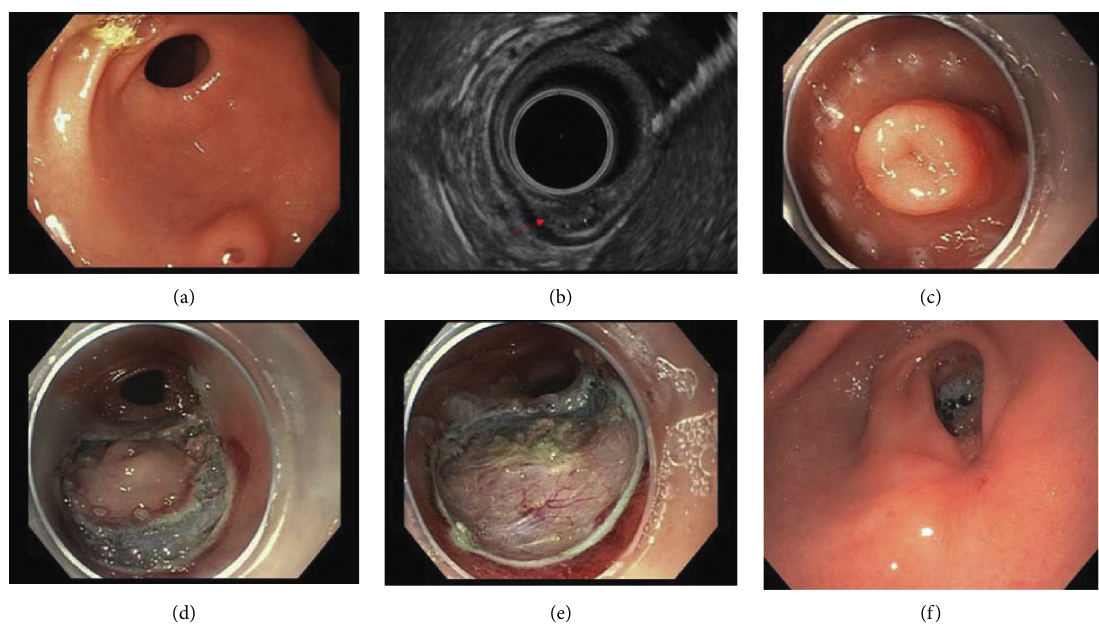
Figure 1: ESD of pancreatic rest and EUS. (a) Visualization of umbilicated lesion and gastric outlet. (b) EUS showing the contained submucosal mass (arrow) below scope. (c) Circumferential marking of region for ESD. (d) Circumferential dissection of lifted lesion. (e) Fully resected lesion. (f) EGD of area at 11 weeks after